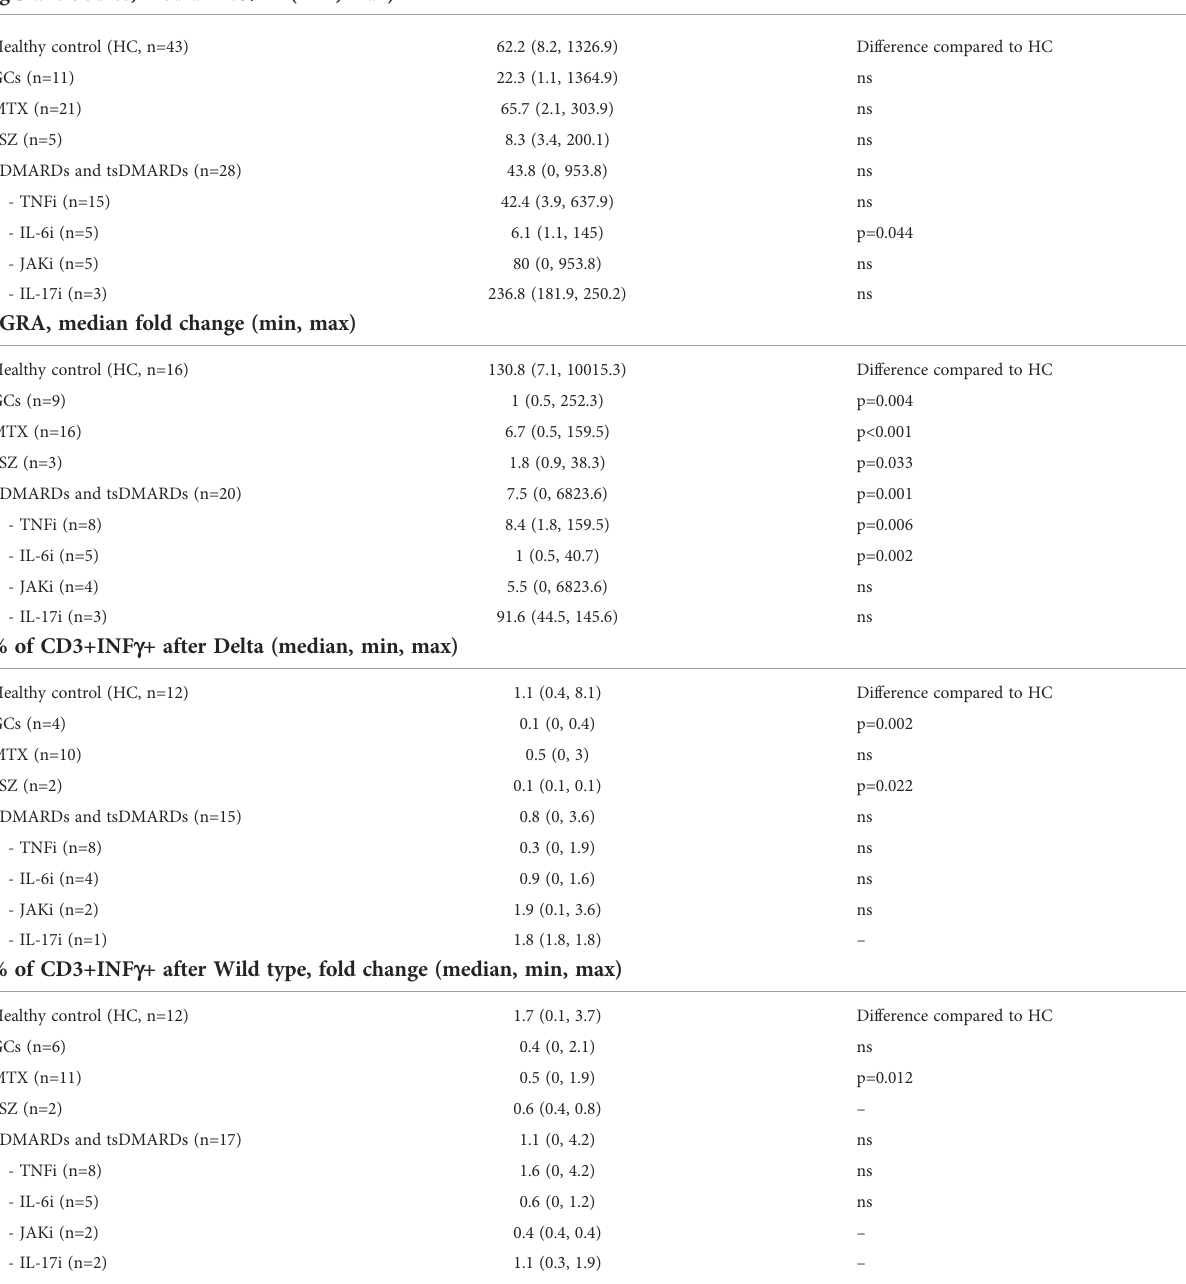
TABLE 3A Effect of immunomodulating drugs on the immunogenicity of the COVID-19 vaccines more than 6 months from primary vaccination. IgG antibodies, median RU/ml (min,